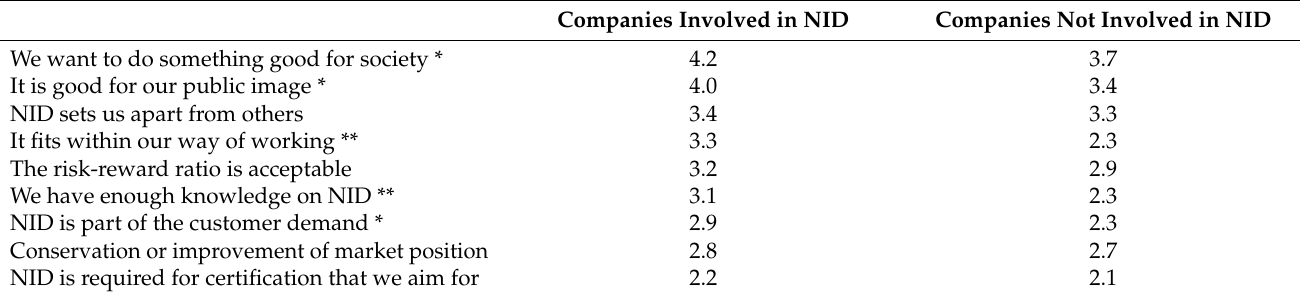
Table 3. Main motivations for engaging in NID on a 1–5 Likert scale ( n = 88).